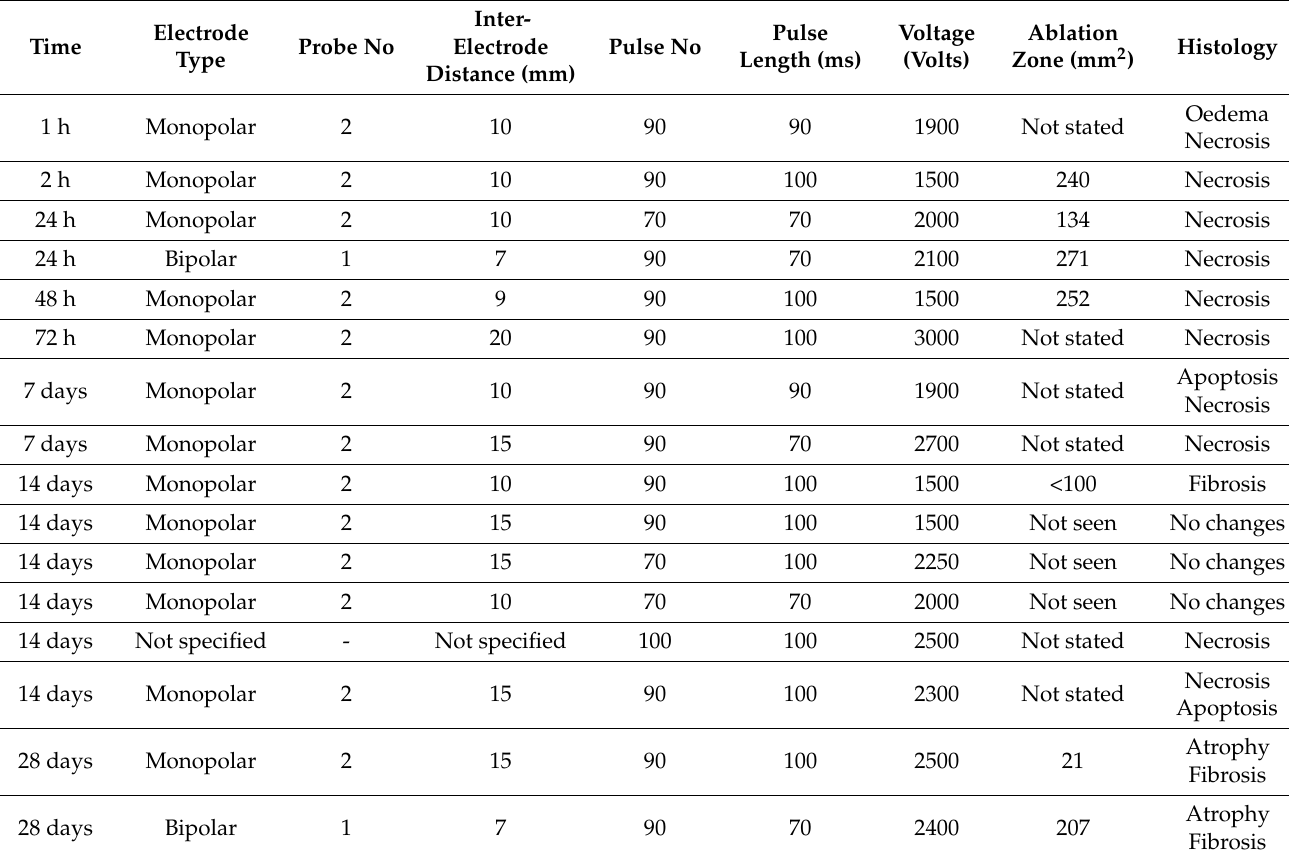
Table 3. Histological changes at specific IRE setting and time course following IRE in normal porcine pancreas [23,24,99].